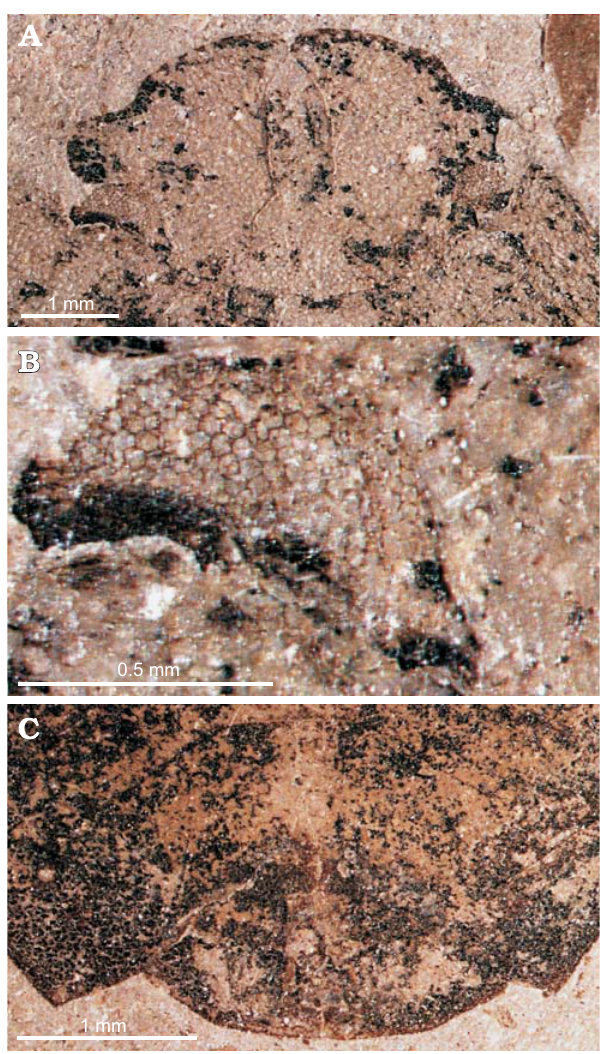
Fig. 3. Details of dorsal habitus of female of pentatomoid bug Chinche- koala qunita gen. et sp. nov., holotype MPEF-PI 944a from Laguna del Hunco (Chubut, Argentina); Ypresian, lower Eocene. Head ( A ), eye ( B ), last tergites ( C